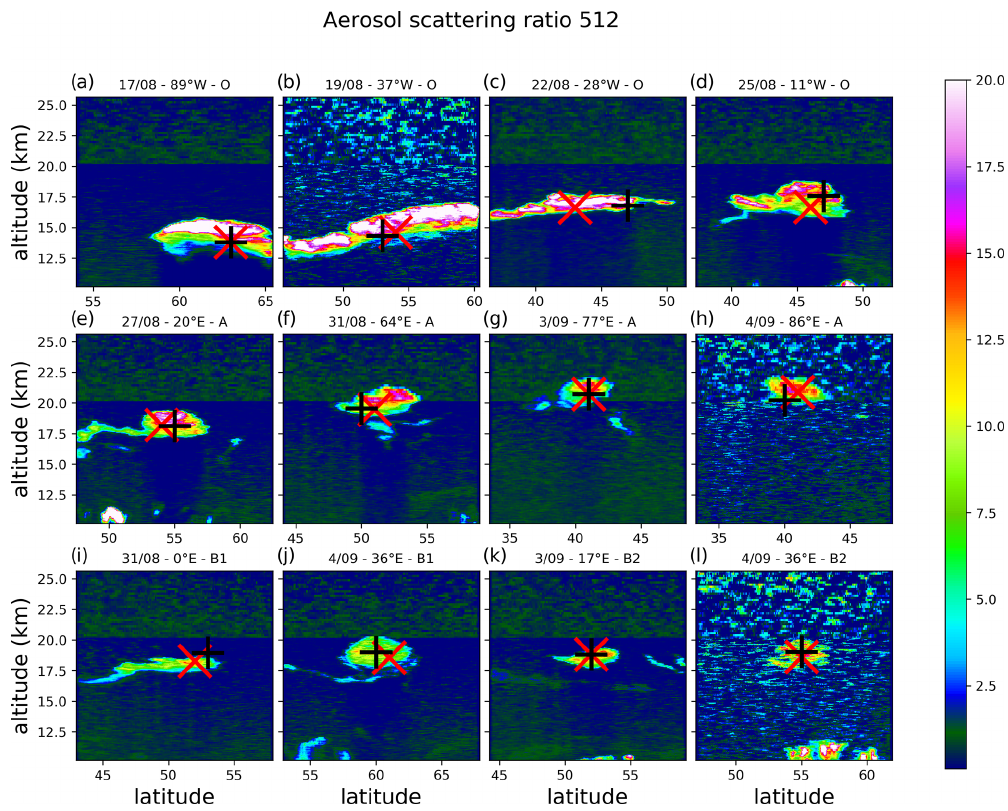
Figure 1. Selection of along-track sections of the CALIOP scattering ratio profiles during the first observation period until 4 September 2017. Panels (a–d) show sections of bubble O at four times. Panels (e–h) show four sections of bubble A after its separation from bubble O. Panels (i–l) show two sections of bubble B1 after its separation from bubble O (i, j) and two views of bubble B2 that continues the track of bubble O after 1 September 2017 (k, l) . In each panel, the black and red crosses show the orbital plane projection of the corresponding vortex centre according to the Lait PV (cid:53) and ozone tracking in ERA5 data respectively. For each panel, the longitude indicated in the title is that of the CALIPSO orbit at the centre of the